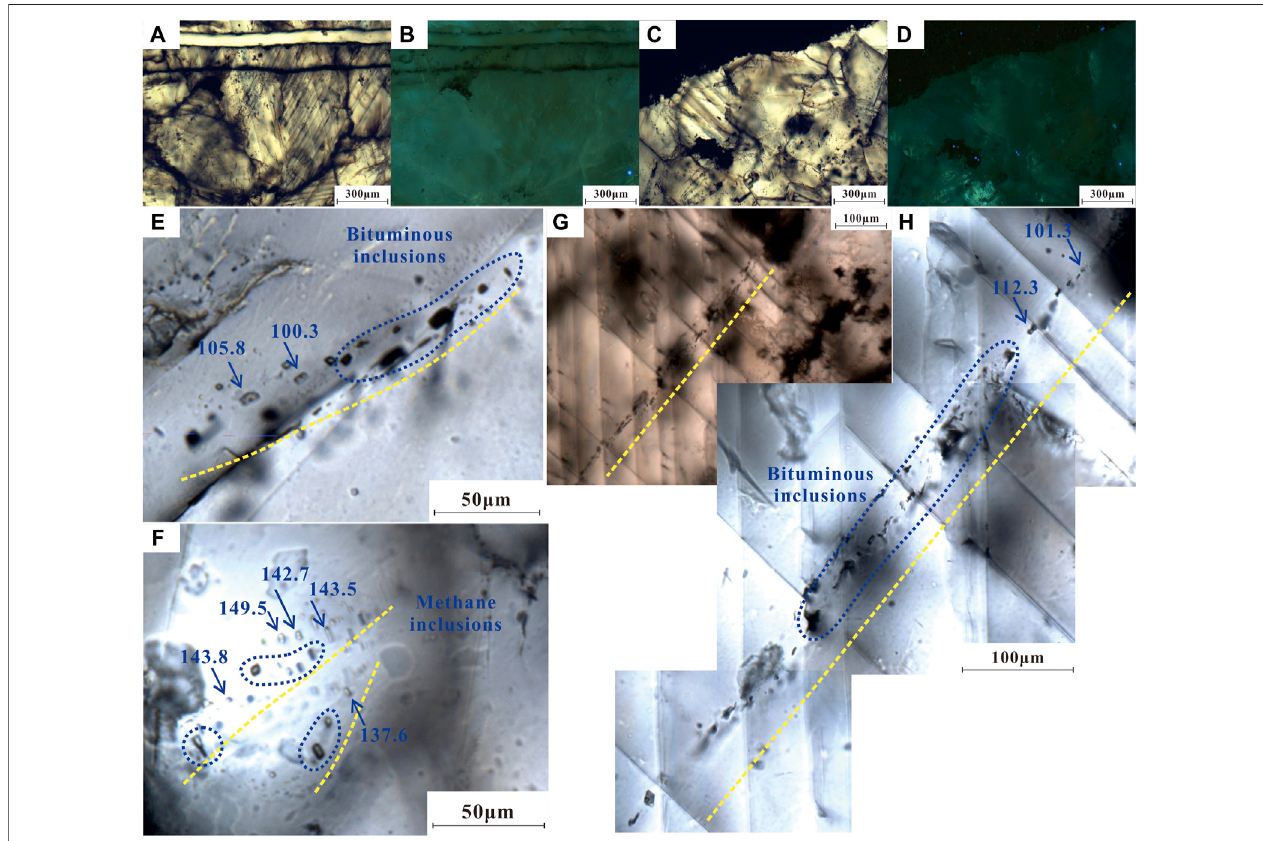
FIGURE 4 | (A) and (B) Micrographs under the transmitted light and fl uorescence of sample N228-3479.4 m, methane inclusions do not fl uoresce; (C) and (D) micrographsunderthetransmittedlightand fl uorescenceofsampleN228-3470.1 m,bituminousinclusionsdonot fl uoresce; (E) blacksecondary bituminousinclusions in sample N228-3469.1 m, and Th of the gas – liquid two-phase aqueous inclusions symbiotic with bituminous inclusions varies from 100.3 to 105.8 ° C; (F) bright in the middle and surrounded by light gray secondary methane inclusions in sample N228-3456.3 m, and Th of the gas – liquid two-phase aqueous inclusions symbiotic with methane inclusions vary from 137.6 to 149.5 ° C; (G) and (H) secondary FIA at different magni fi cation in sample N228-3470.1 m with Th ranges from 101.3 to 112.3 ° C.